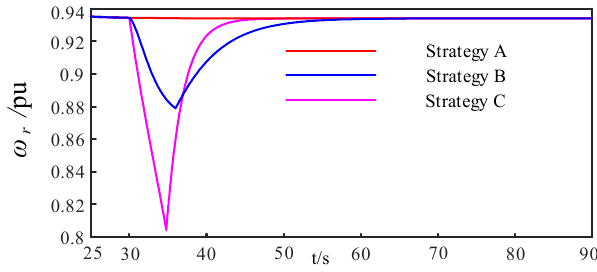
Figure 9. Rotor speed responses under different control strategies.